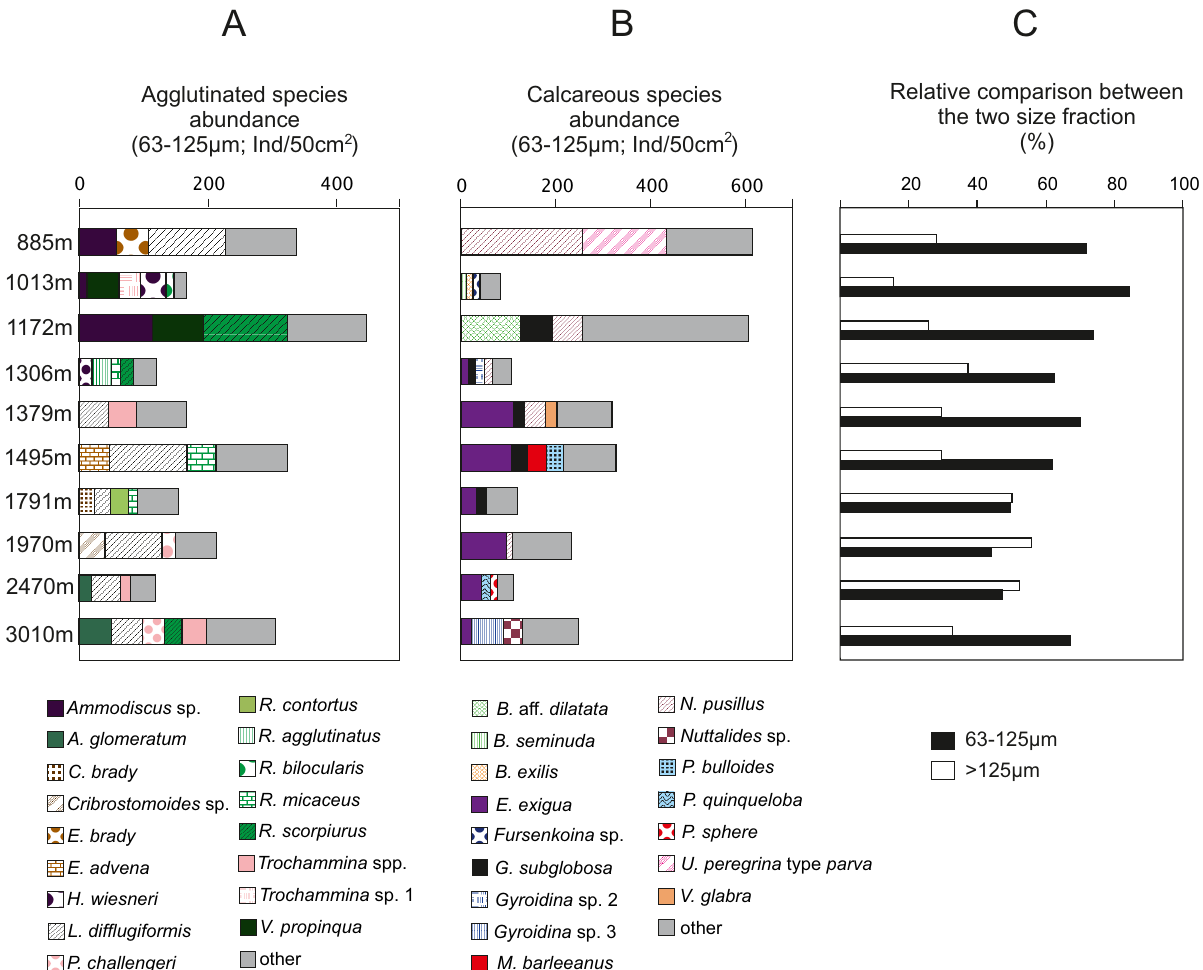
Fig. 5. (A) Species composition and abundance (ind/50cm 3 ) in the 63–125µm fraction for the upper centimetre of the sediment for ag- glutinated species ( > 5%). (B) Species composition and abundance (ind/50cm 3 ) in the 63–125µm fraction for the upper centimetre of the sediment for calcareous species ( > 5%). (C) Relative contribution of the two size fractions (63–125µm and > 125µm) to the foraminiferal faunas in the 0–1cm